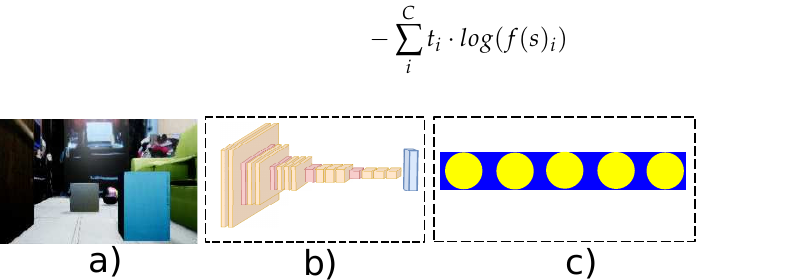
Figure 14. Path-planning generator based on the auto-encoder approach. ( a ) Input sample. ( b ) Fea- ture extraction network. ( c ) Generative path